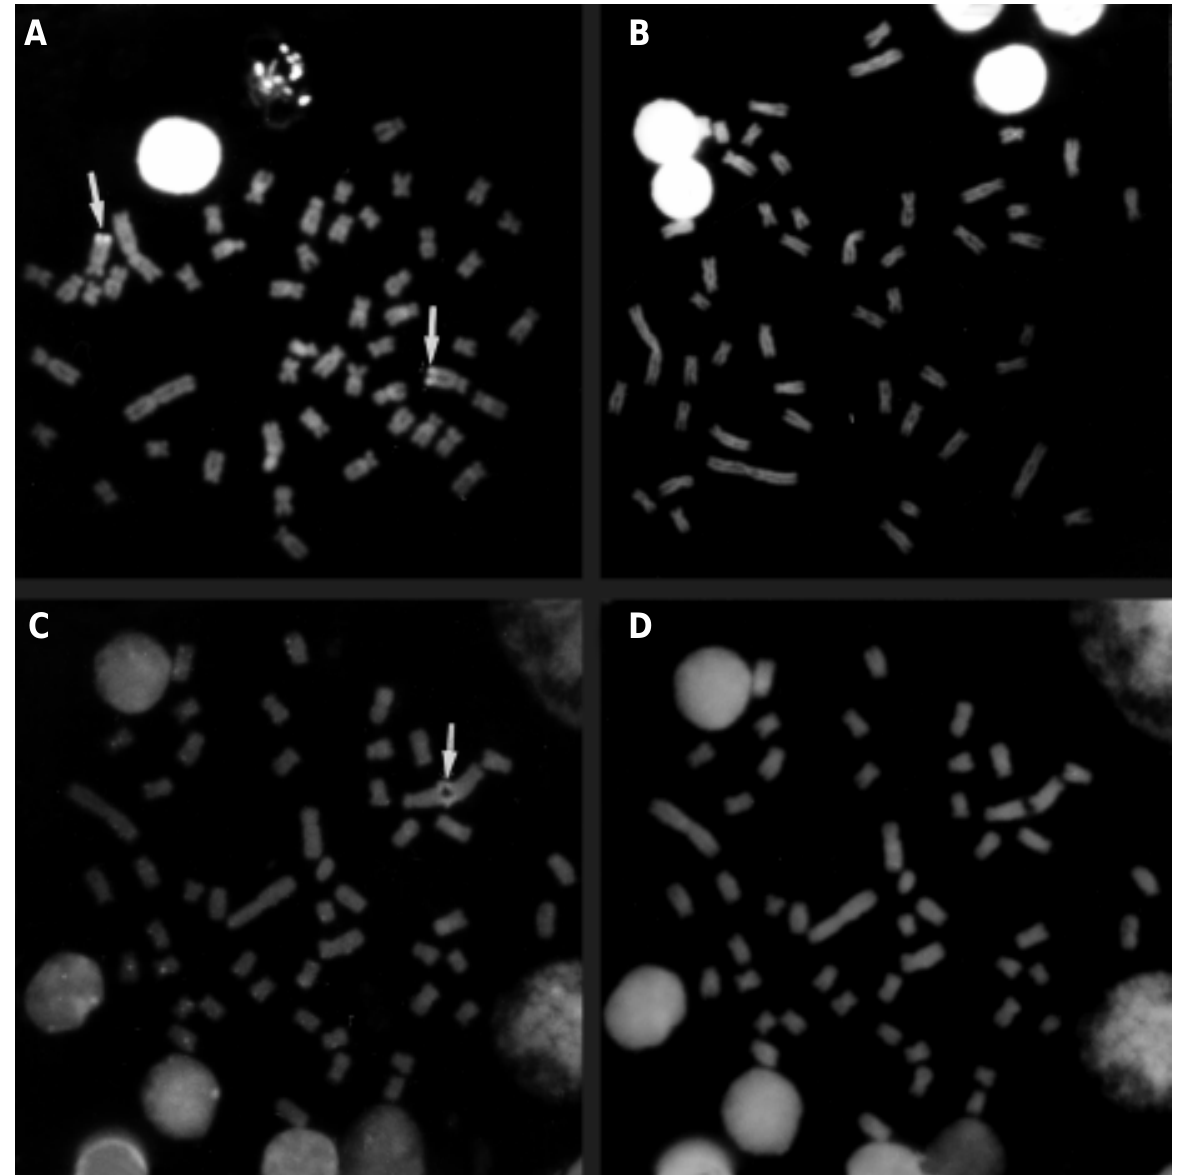
Figure 2 - Metaphases stained by mithramycin in (A) Brycon lundii and (C) Brycon microlepis , and by DAPI in (B) Brycon lundii and (D) Brycon microlepis . Mithramycin positive bands are indicated by